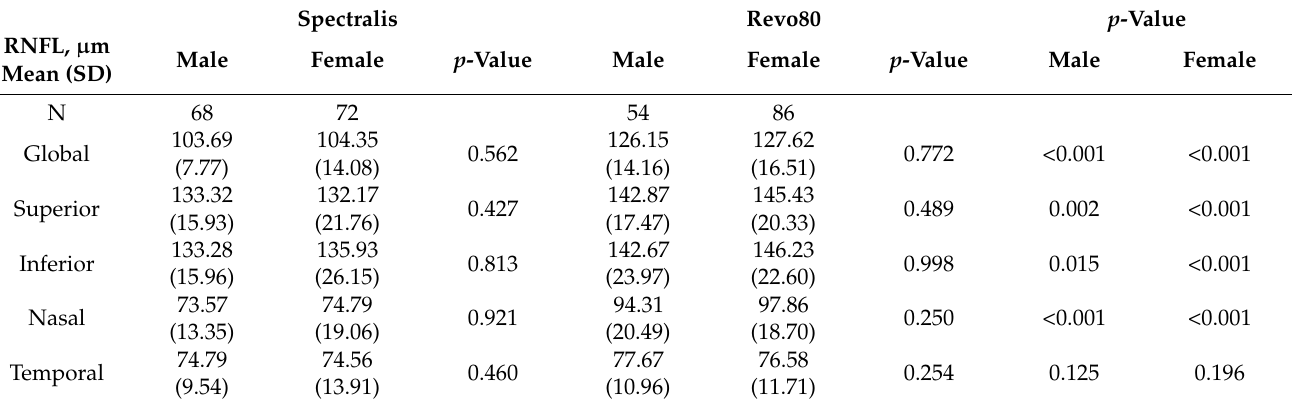
Table 5. Means (filtered by gender) for global and sectorial RNFL